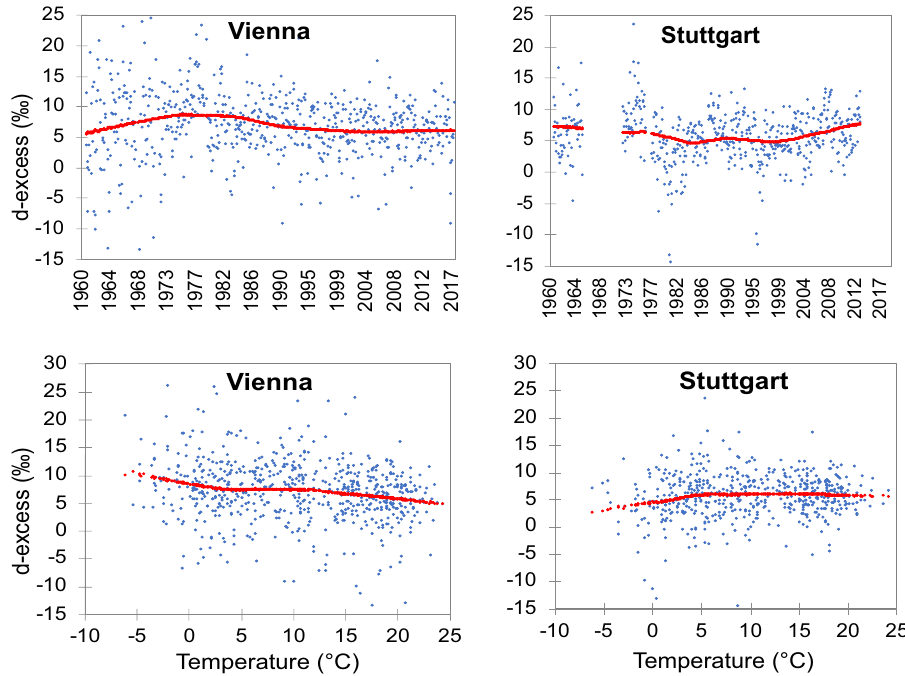
Figure 5. Nonparametric regression of d -excess variations over time and d -excess relationships with temperature for Vienna and Stuttgart ( R 2 was ~ 5% for each trend that was significant at p <